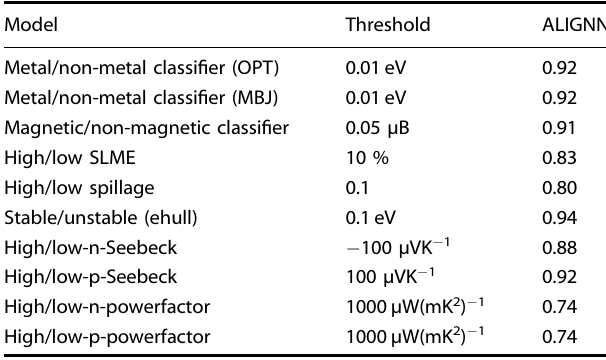
Table 4. Classi fi cation task ROC AUC performance on JARVIS-DFT dataset for ALIGNN models.